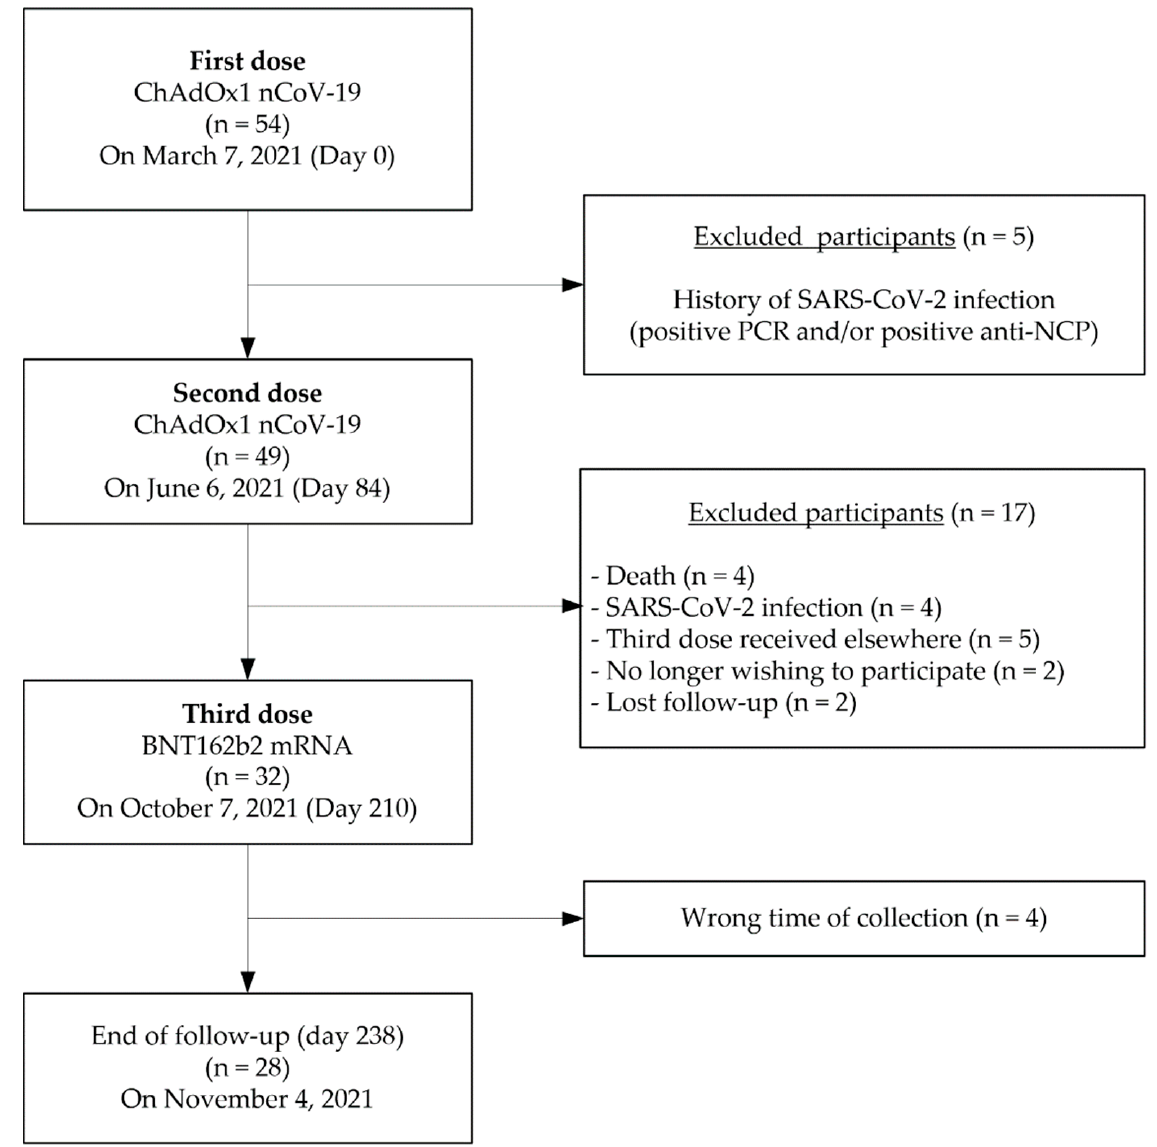
Figure 1. STROBE, STrengthening the Reporting of OBservational studies in Epidemiology. Five LTRs with previous SARS-CoV-2 infection (documented by a positive PCR and/or positive antibodies against the nucleocapsid (NCP)) were excluded. Forty-nine